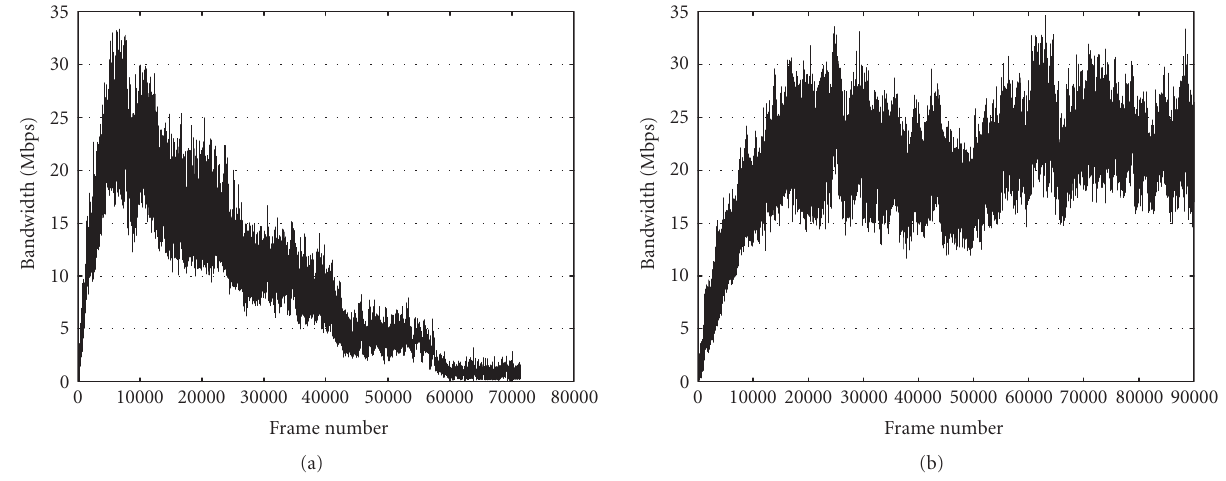
Figure 2: (a) Composite static tra ffi c aggregate, (b) composite dynamic tra ffi c aggregate.